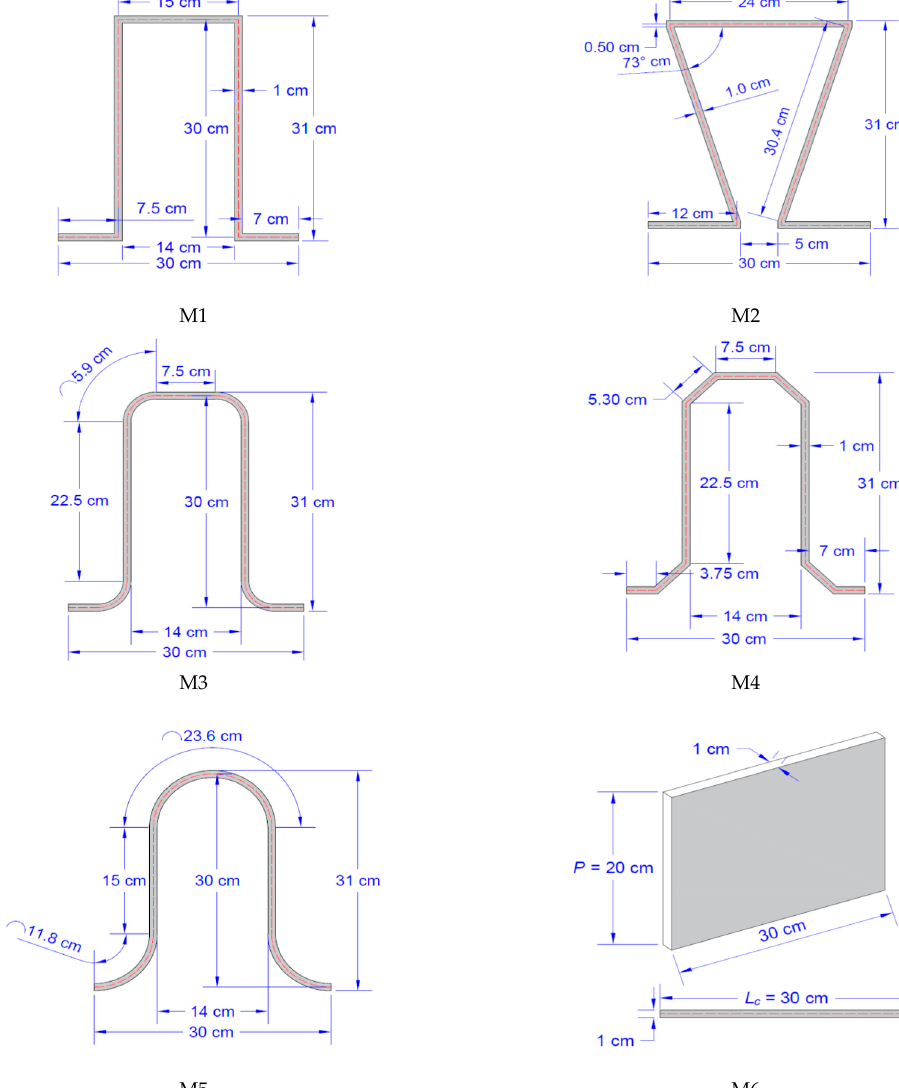
Figure 3. Plan views of the weir models used in this investigation .